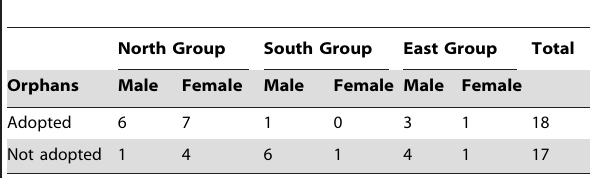
Table 1. Number of orphans and adoptions seen in the 27 years of observation of three study groups of the Taı¨ chimpanzee project.